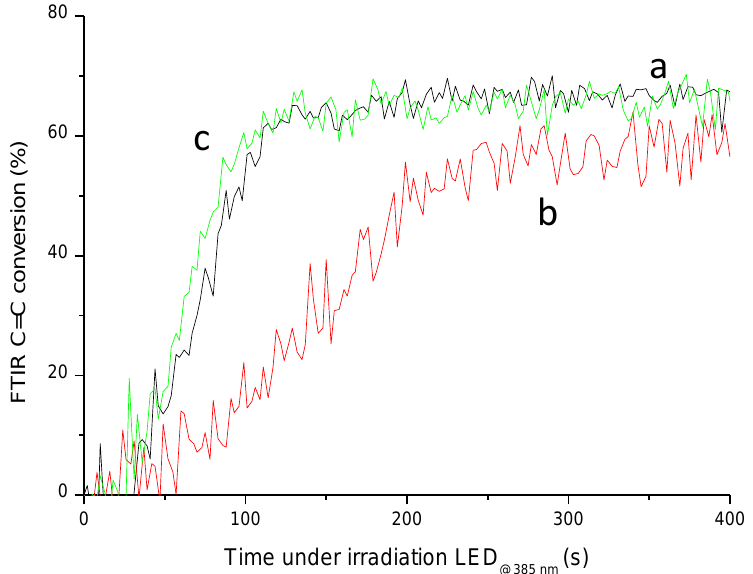
Figure 3. Photopolymerization profiles (methacrylate function conversion vs. time) of a 1.4 mm-thick BisGMA/TEGDMA methacrylate resin, under air, upon irradiation with a LED@385 nm (20 mW/cm 2 ), initiated by different Type I PIs in combination with NHC-borane 4 : (a) Irgacure 1173 (1% w / w ) and 4 (2% w / w ), (b) 1 (1% w / w ) and 4 (2% w / w ), and (c) 2 (1% w / w ) and 4 (2% w / w ). The irradiation starts at t = 10 s.